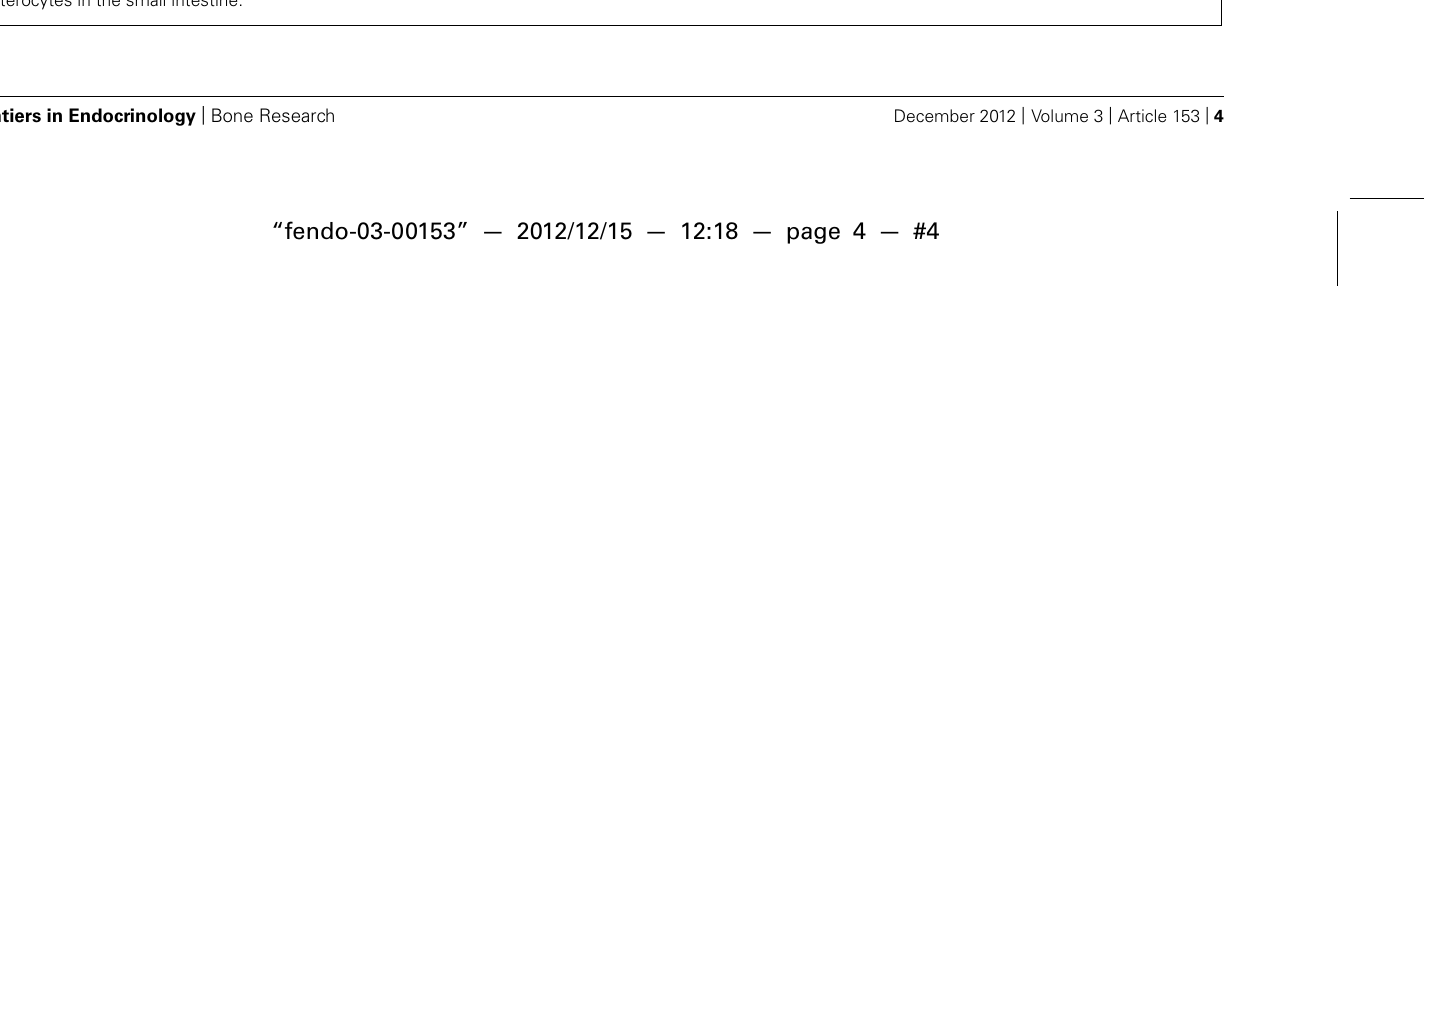
Frontiers in Endocrinology | Bone